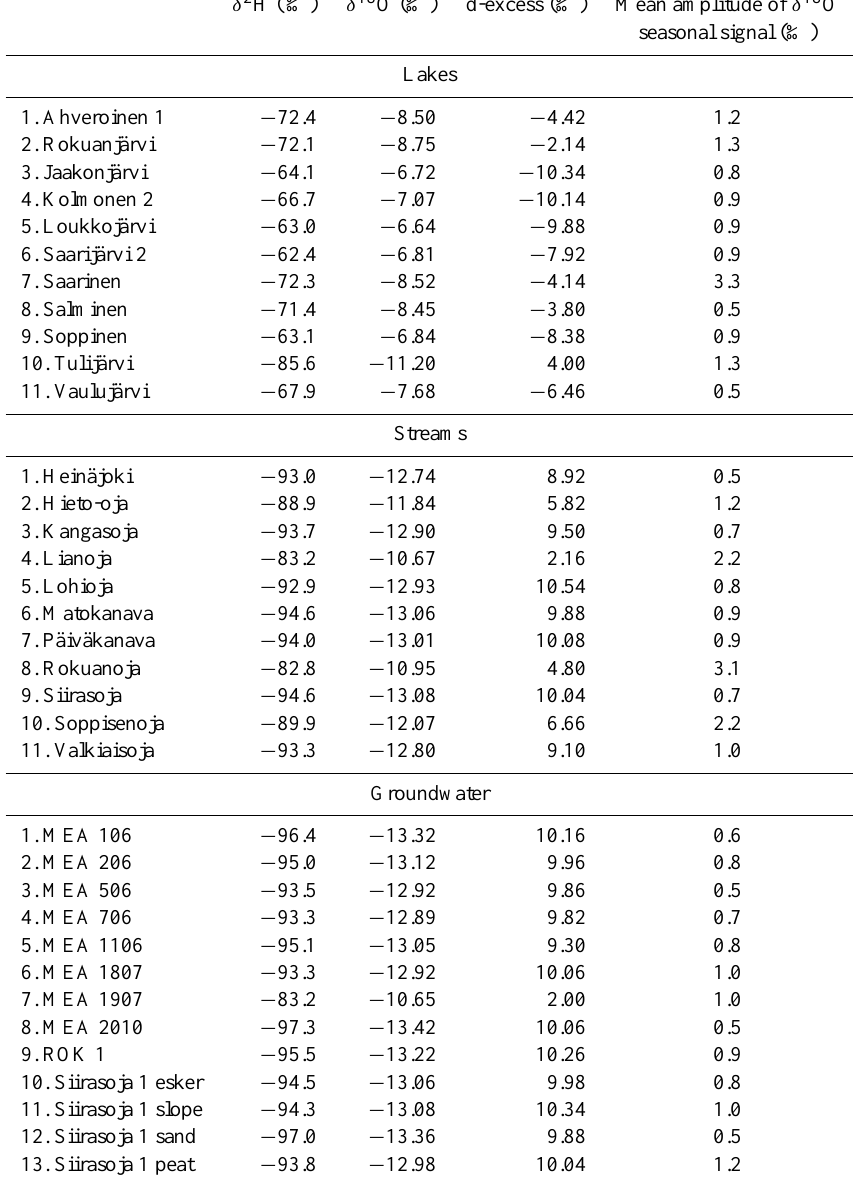
Table 1. Mean isotopic composition of selected lakes, streams and groundwater, sampled four times per year during the period 2010–2012. δ 2 H (‰) δ 18 O (‰) d-excess (‰) Mean amplitude of δ 18 O seasonal signal